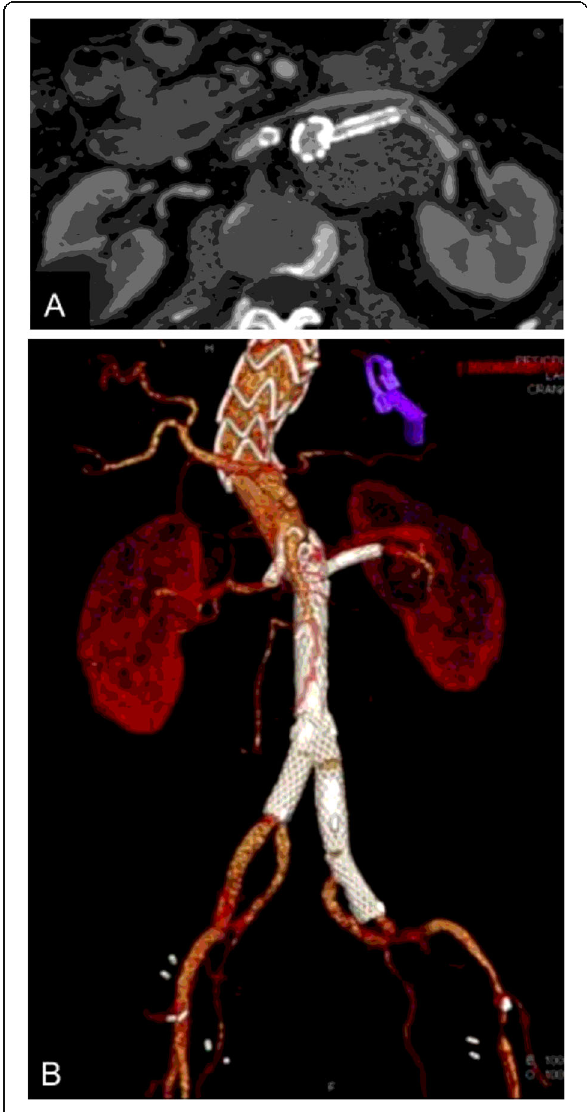
Fig. 3 a Axial contrast-enhanced image showing patency of the left renal connection stent with complete thrombosis of the aortic aneurysm. b 3D RECONSTRUCTION SHOWING PATENCY OF ALL SPLA nchnic arteries, reconstitution of flow through de TL and patency of both hypogastric